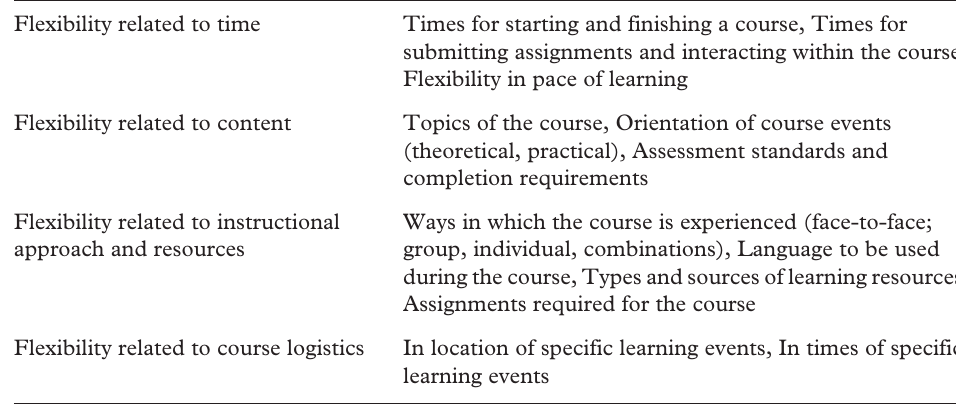
Table 1. Instructor choices in flexibility, grouped according to main categories Flexibility related to time Times for starting and finishing a course, Times for submitting assignments and interacting within the course, Topics of the course, Orientation of course events (theoretical, practical), Assessment standards and Ways in which the course is experienced (face-to-face; group, individual, combinations), Language to be used during the course, Types and sources of learning resources, Assignments required for the